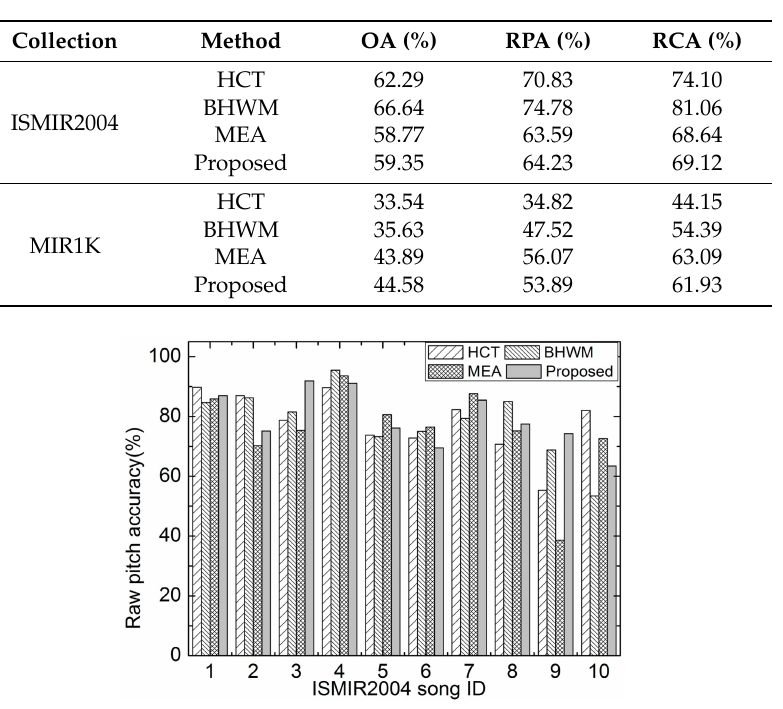
Table 2. Accuracies of different methods on ISMIR2004 and MIR1K.